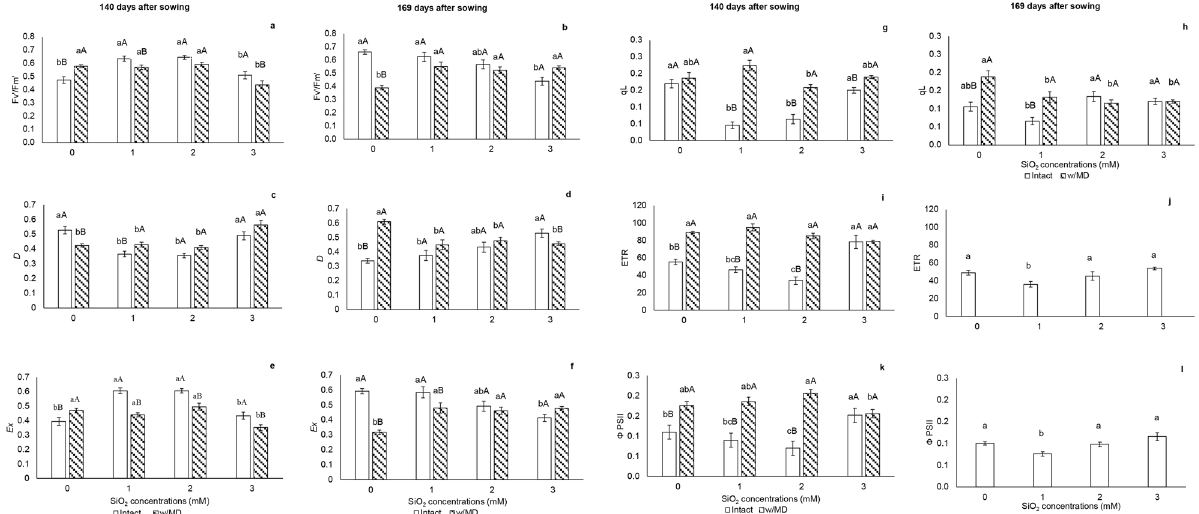
Figure 1. Chlorophyll a fluorescence. ( a , b ) Potential quantum efficiency of open PSII center (Fv ′ /Fm ′ ) p < 0.01; ( c , d ) energy fraction absorbed by PSII antenna that is dissipated as heat ( D ) p < 0.01; ( e , f ) energy fraction not dissipated in the antenna that cannot be used for photochemistry stage ( Ex ) p < 0.01; ( g , h )